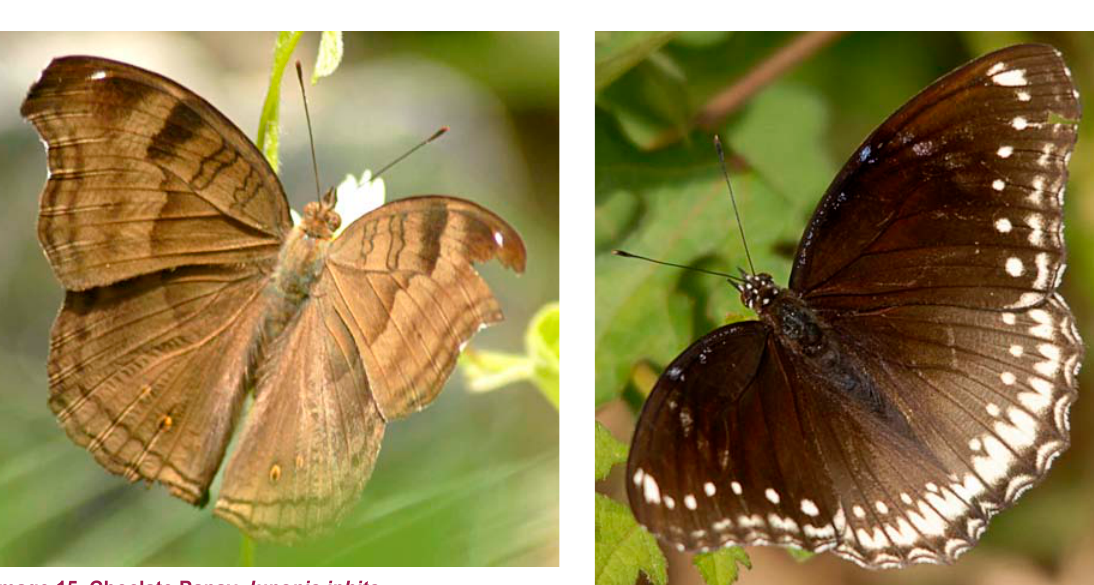
Image 14. Great Eggfly Hypolimnas bolina